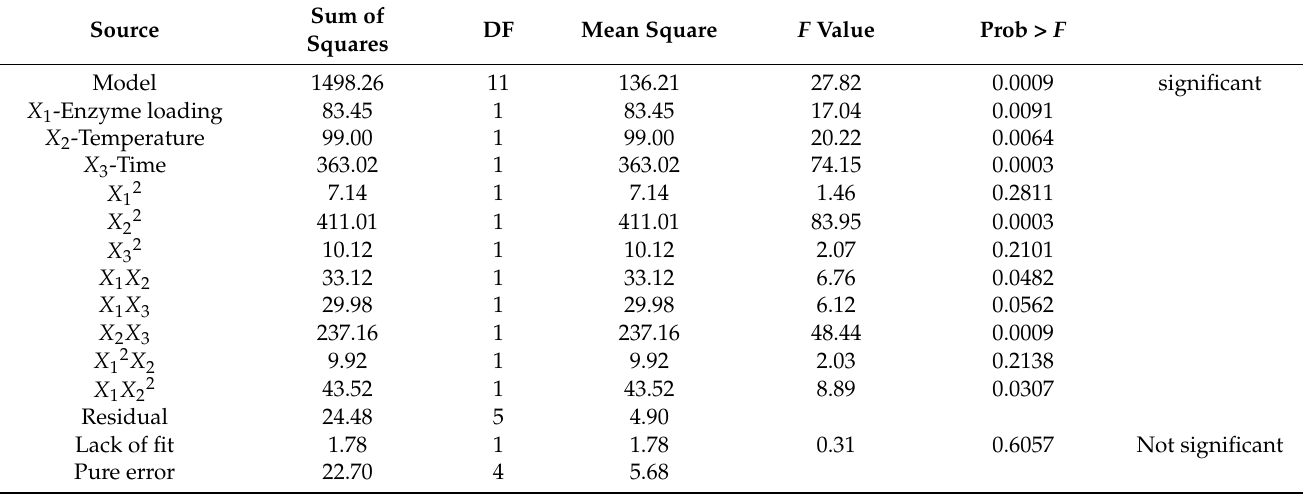
Table 2. ANOVA data for the enzymatic hydrolysis response